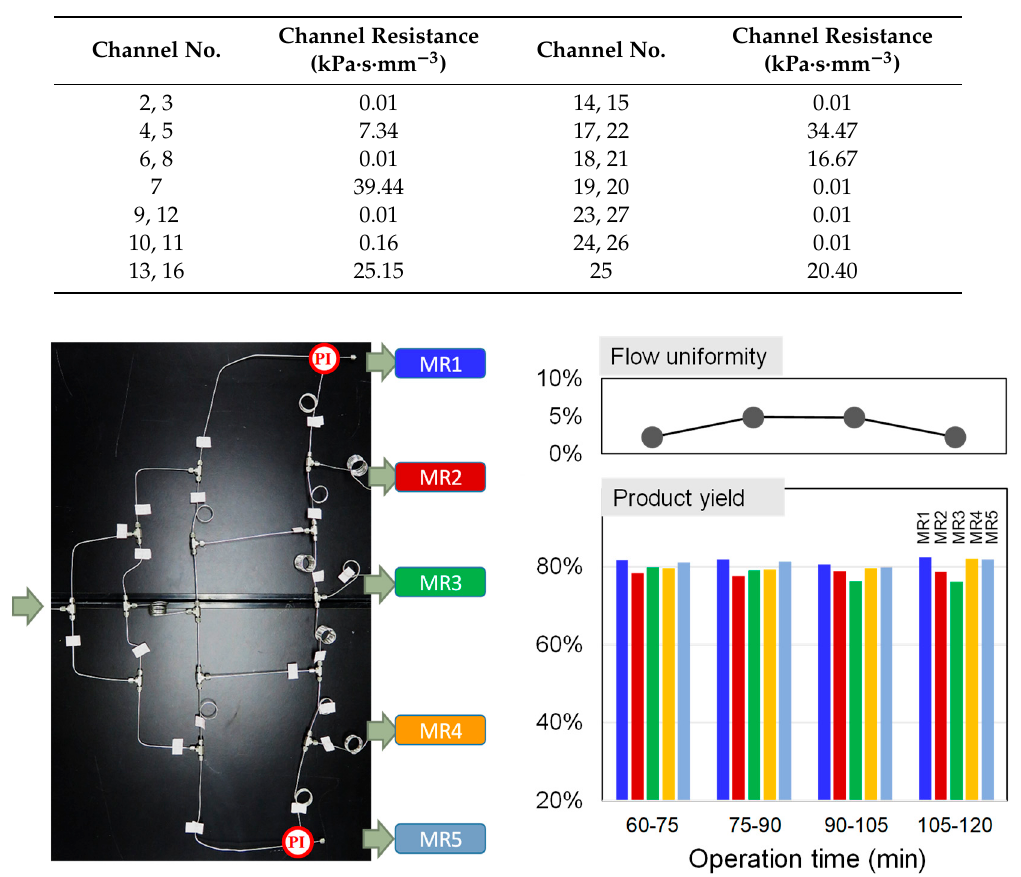
Table 2. Resistances of channels in the SRFD.